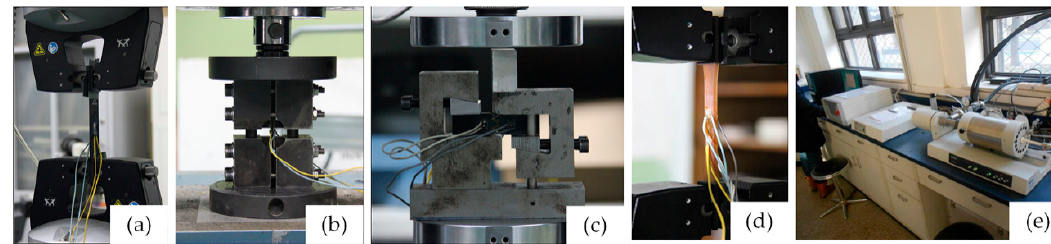
Figure 2. Experiments for basic mechanical properties of the T300/5228A laminates: ( a ) Tension; ( b ) Compression; ( c ) Shear; ( d ) Tension of matrix; ( e ) Thermomechanical analysis of matrix.